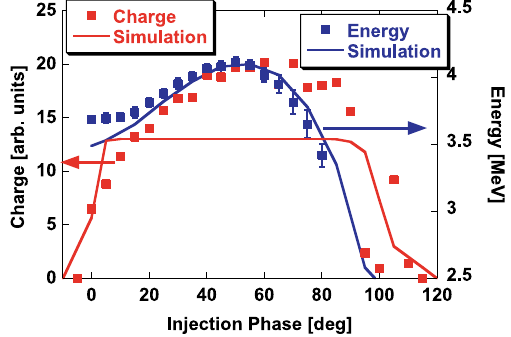
FIG. 12 (color online). Results of charge and energy measure- ment as a function of injection phase. The dots and lines show measurement results and simulation results, respectively. Measurement and simulation show good agreement.